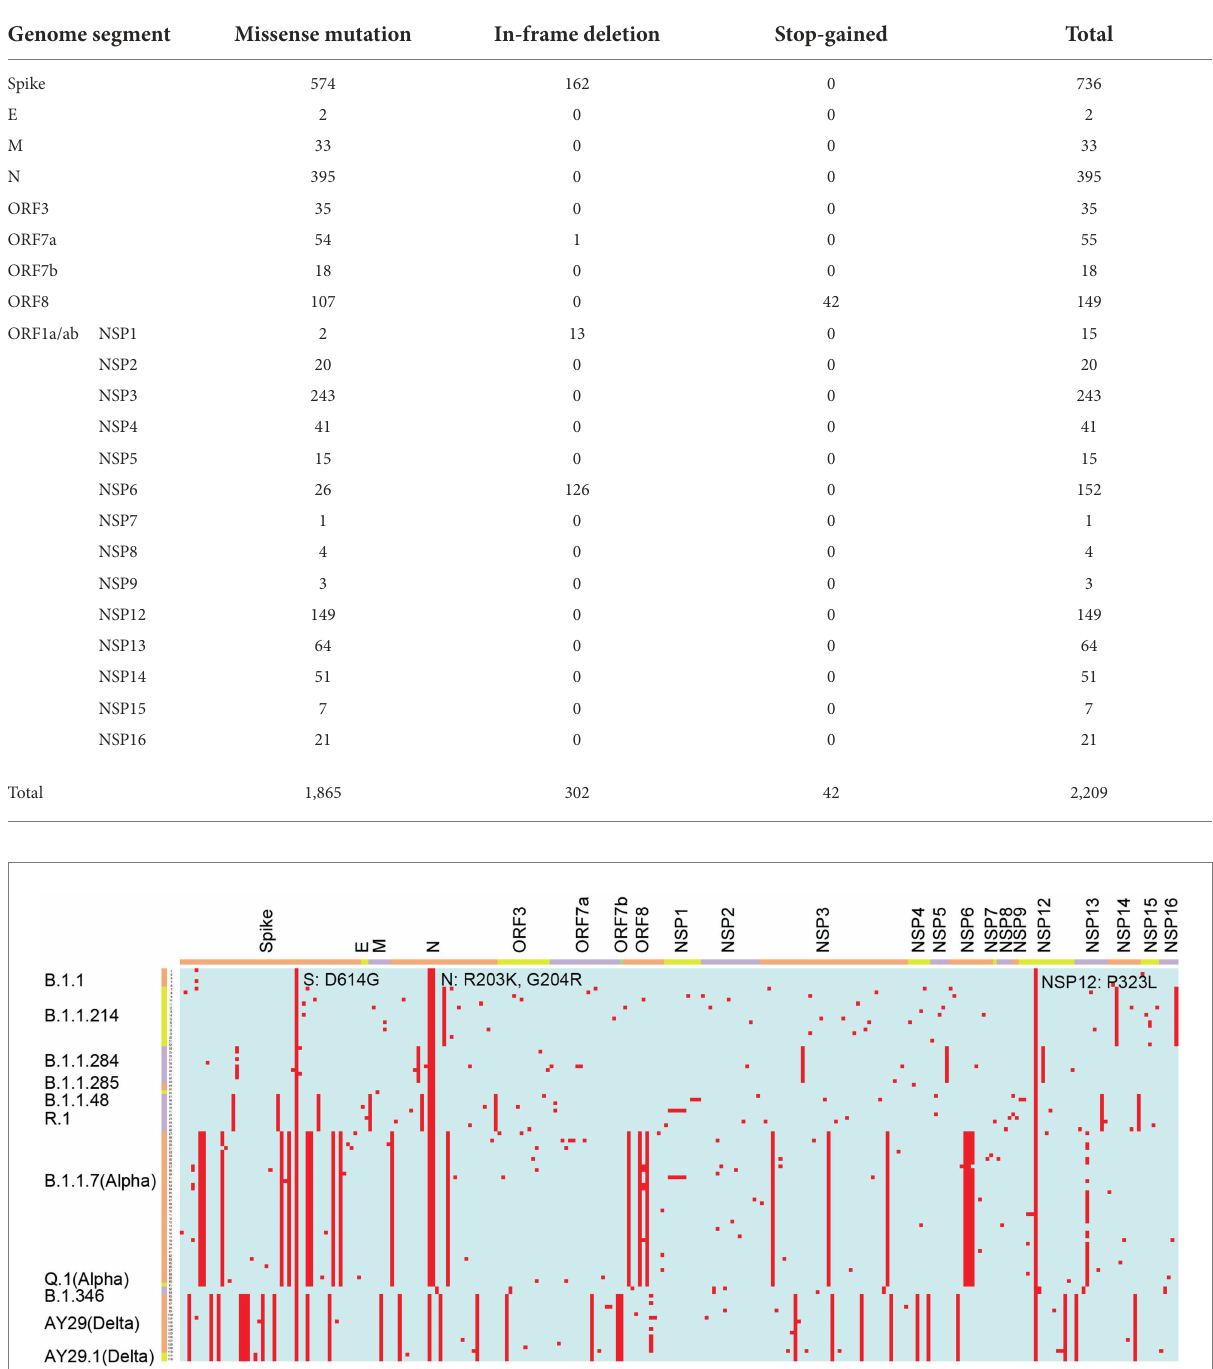
TABLE 1 The number of amino acid changes observed in SARS-CoV-2 sequenced at Juntendo University Hospital.